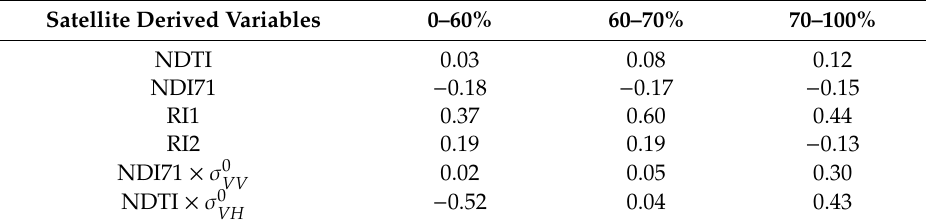
Table 6. The mean value of some satellite derived variables in three